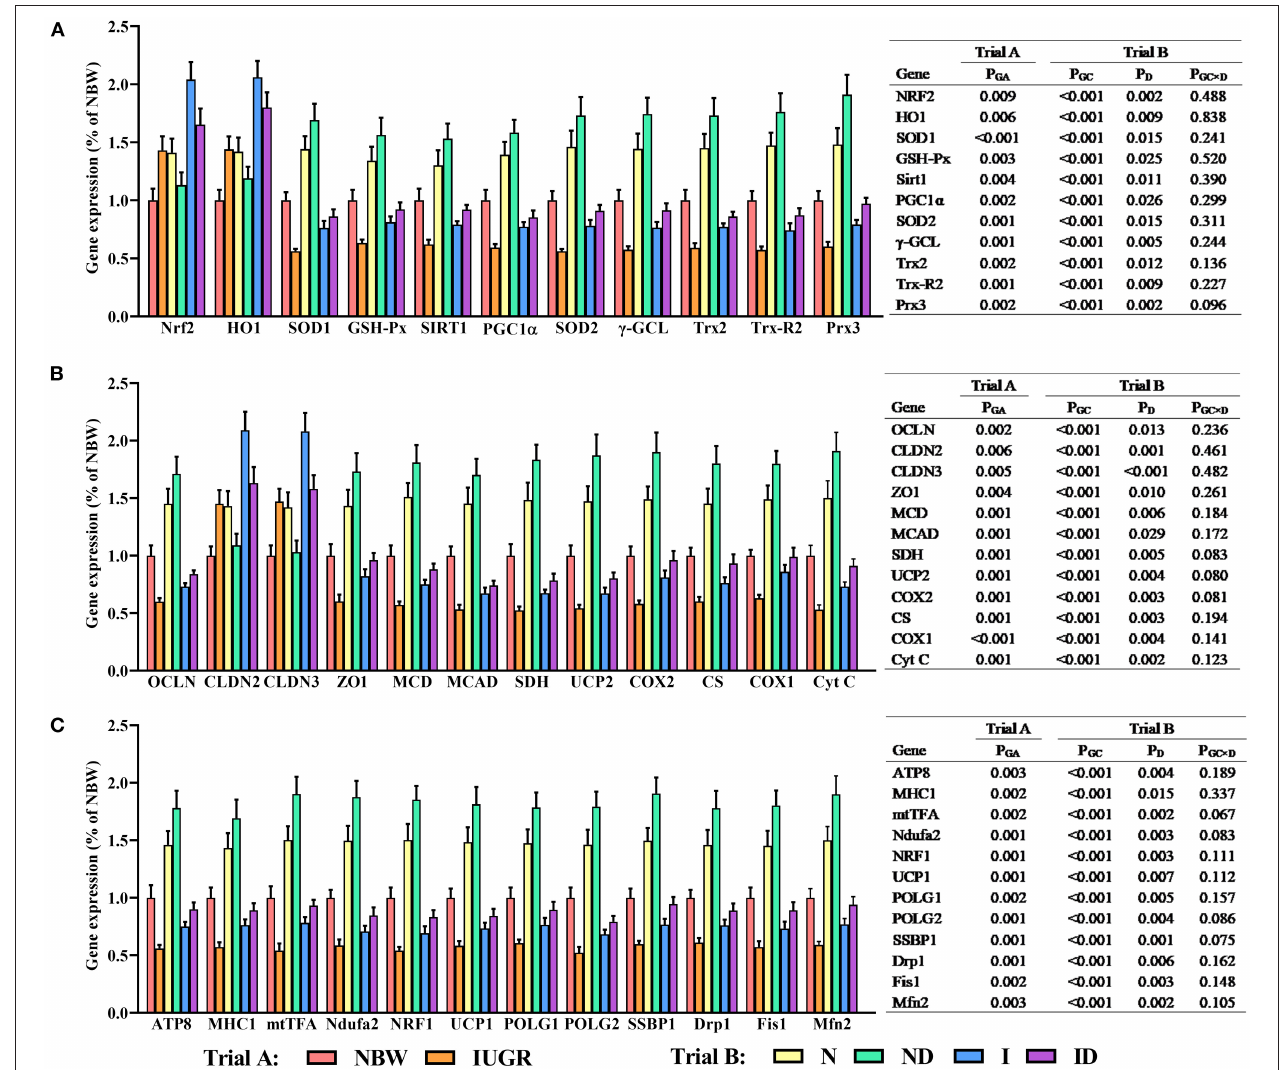
FIGURE 8 | (A–C) Supplementation with DMG-Na improved the hepatic gene expression values in IUGR suckling piglets. Data are expressed as the mean ± SD; n = 10 suckling piglets per group. The P -value (Trial A: NBW, IUGR group in black color) and a, b, c, d (Trial B: N, ND, I, ID group in red color) represent significant differences ( P < 0.05). NBW, normal birth weight newborns; IUGR, intrauterine growth restriction newborns; N, NBW newborns fed a basic milk diet; ND, NBW newborns fed a basic milk diet plus 0.1% DMG-Na; I, IUGR newborns fed a basic milk diet; ID, IUGR newborns fed a basic milk diet plus 0.1% DMG-Na. Nrf2, nuclear factor erythroid 2-related factor 2; HO1, heme oxygenase 1; SOD1, copper and zinc superoxide dismutase; GSH-Px, glutathione peroxidase; Sirt1, sirtuin 1; PGC1 α , peroxisome proliferator-activated receptor γ coactivator-1 α ; SOD2, manganese superoxide dismutase; γ -GCL, γ -glutamylcysteine ligase; Trx2, thioredoxin 2; Trx-R2, thioredoxin reductase 2; Prx3, peroxiredoxin 3; OCLN, occluding; CLDN2, cloudin2; CLDN3, cloudin3; ZO1, zonula occludens-1; MCD, lipid oxidation enzymes malonyl-CoA decarboxylase; MCAD, medium-chain acyl-CoA dehydrogenase; SDH, mitochondrial proteins succinate dehydrogenase; UCP2, uncoupling protein 2; COX2, cyclooxygenase 2; CS, citrate synthase; COX1, cyclooxygenase 1; Cyt C, Cytochrome C; MHC1, major histocompatibility complex I; mtTFA, mitochondrial transcription factor A; Ndufa2, NADH dehydrogenase (ubiquinone) iron-sulfur protein 2; NRF1, nuclear respiratory factor 1; UCP1, uncoupling protein 1; POLG1,